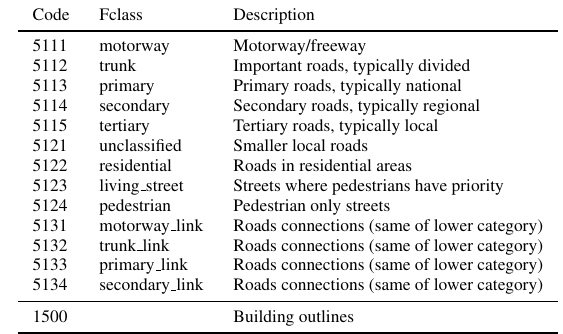
Table 1. Reclassification of OSM vector features into the road and building